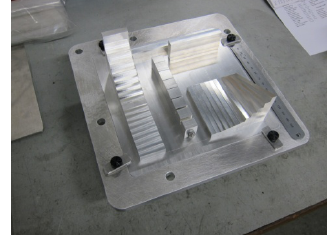
Figure 5. The completed 2D photographic target plate: Left ISO- 16067-1 chart to test resolving power, top right: x-rite colour chart, bottom right: gloss scale.